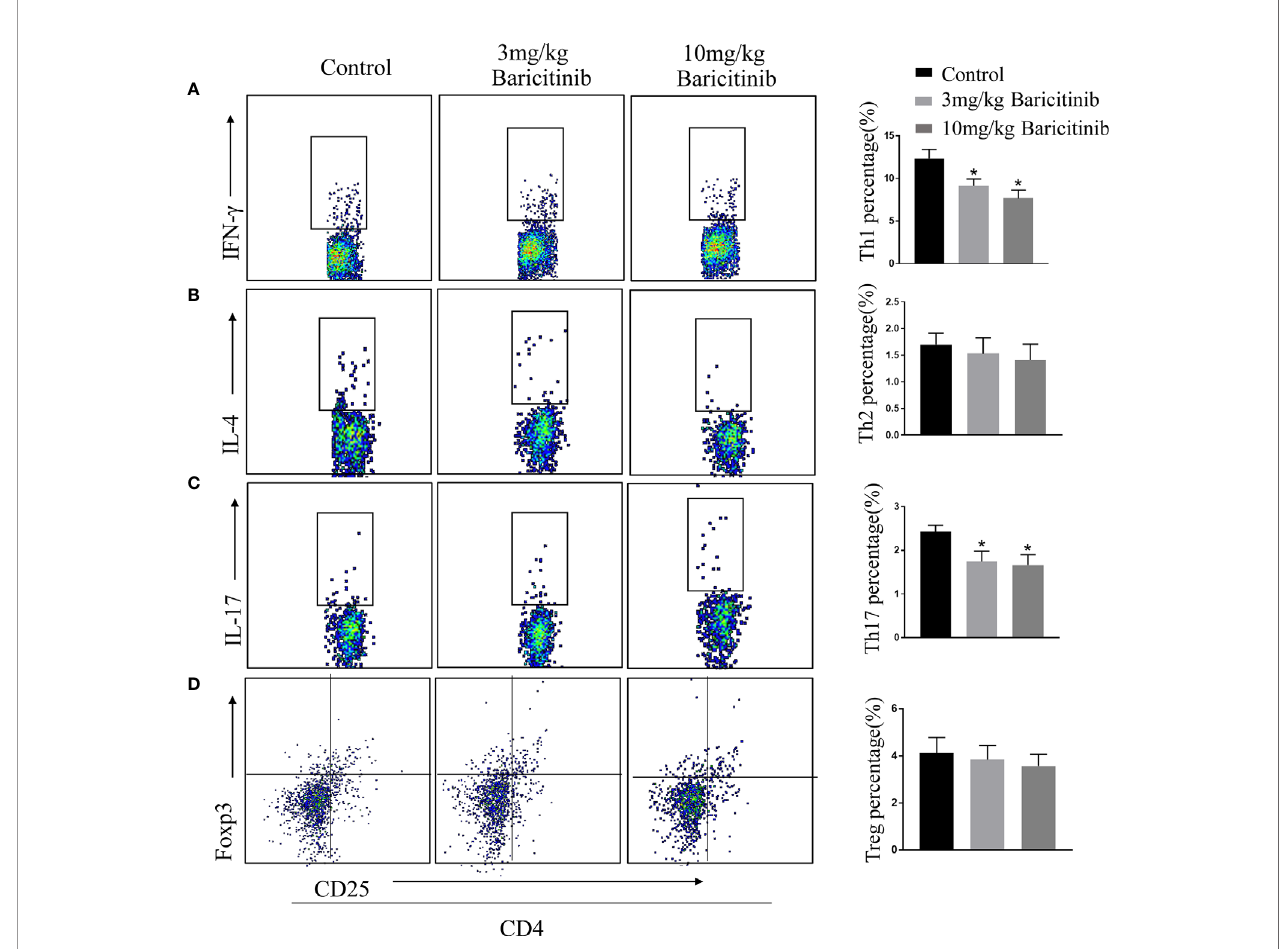
FIGURE 3 | Baricitinib affects the differentiation of T-cells in CNS. At the peak phase of experimental autoimmune encephalomyelitis (EAE), CNS cells were isolated for fl ow cytometry to analyze changes in the differentiation of lymphocytes in spinal cord. The proportions of CD4+IFN- g +Th1 (A) , CD4+IL-4+Th2 (B) , CD4+IL-17+ Th17 (C) and CD4+CD25+Foxp3+ Treg cells (D) of mice from different groups were investigated through fl ow cytometry analysis. The percentages of CD4+IFN- g + Th1 cells and CD4+IL-17+ Th17 cells in the CNS cells were decreased in both the baricitinib-treated groups than in the control group. Compared with the control group, baricitinib treatment did not affect the differentiation of CD4+IL-4+Th2 cells and CD4+CD25+Foxp3+ Treg cells. Quantitative data are the mean ± SEM. * p < 0.05; n = 6 per